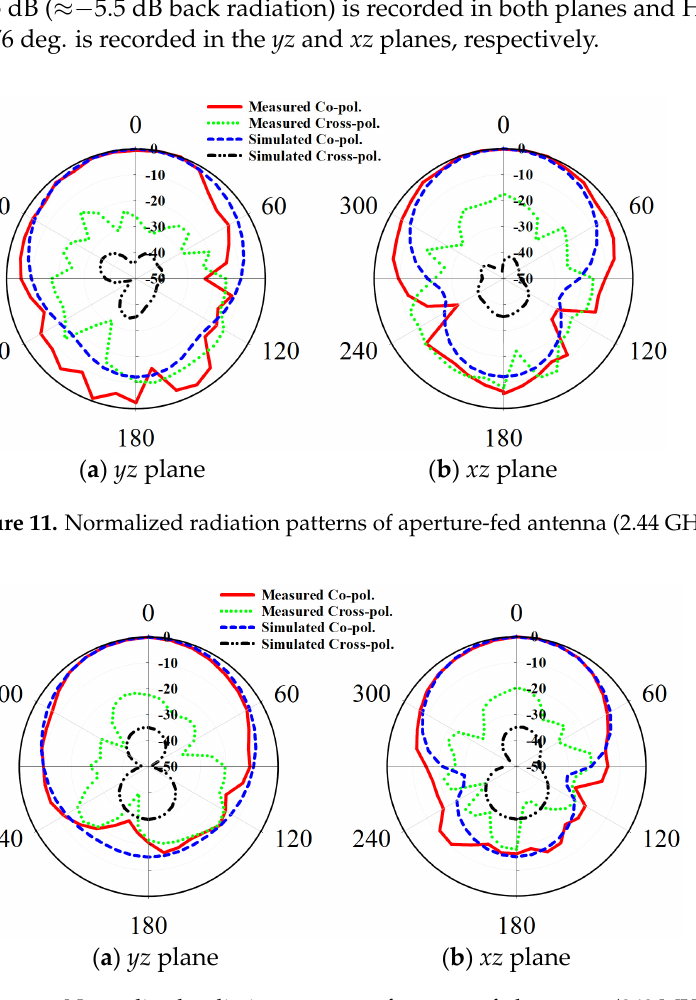
Table 3. Comparison of fabric-based patch antennas with aperture/proximity feeding techniques. Ref.